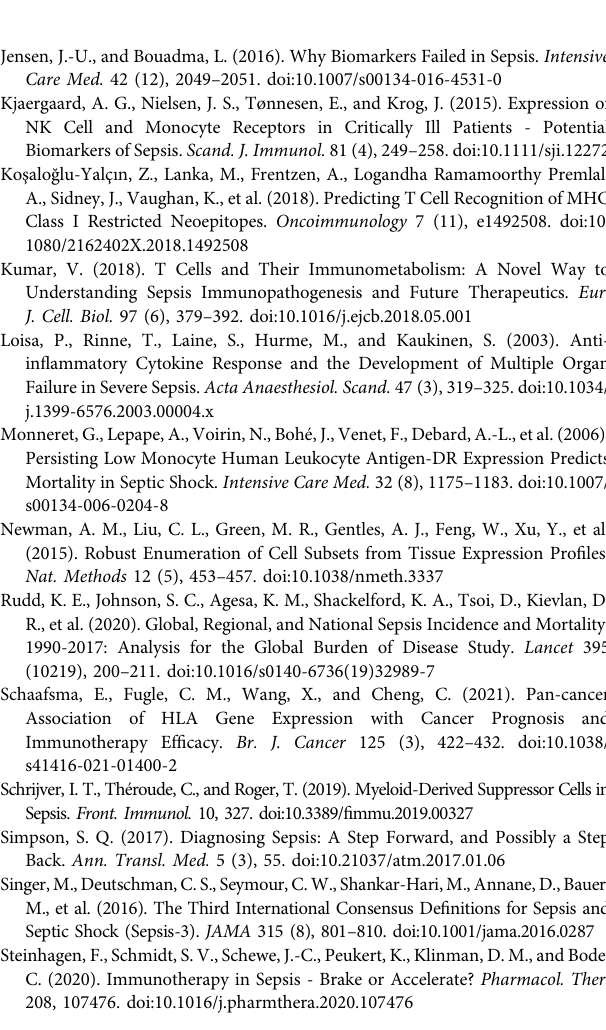
Supplementary Figure S5 | The distribution of mortality rate in different HLA subgroups and the prognostic capacity of the HLA classi fi er in external validation cohorts. (A,B) E-MTAB-4421 datasets. (C,D) E-MTAB-4451 datasets. (E,F) : E-MTAB-7581 datasets. Supplementary Figure S6 | The evaluation of the clinical usefulness of the HLA classi fi erinthediscoverycohorts. (A) GSE54514datasets. (B) GSE63042datasets. Supplementary Figure S7 | The distribution of 22 immune in fi ltration cells in each sepsis sample from GSE65682 datasets. Supplementary Figure S8 | The distribution of 22 immune in fi ltration cells in each sepsis sample from E-MTAB-4421 datasets. Supplementary Figure S9 | The distribution of 22 immune in fi ltration cells in each sepsis sample from E-MTAB-4451 datasets. Supplementary Figure S10 | Bar plot displays differences in pathway activities between different HLA